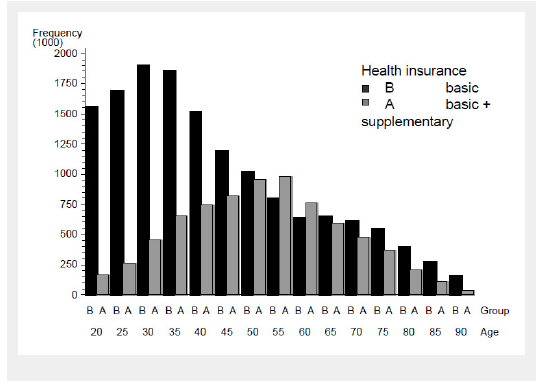
Figure 1 Age distribution of populations with basic or with basic plus supplementary health insurance for 2002–2005.